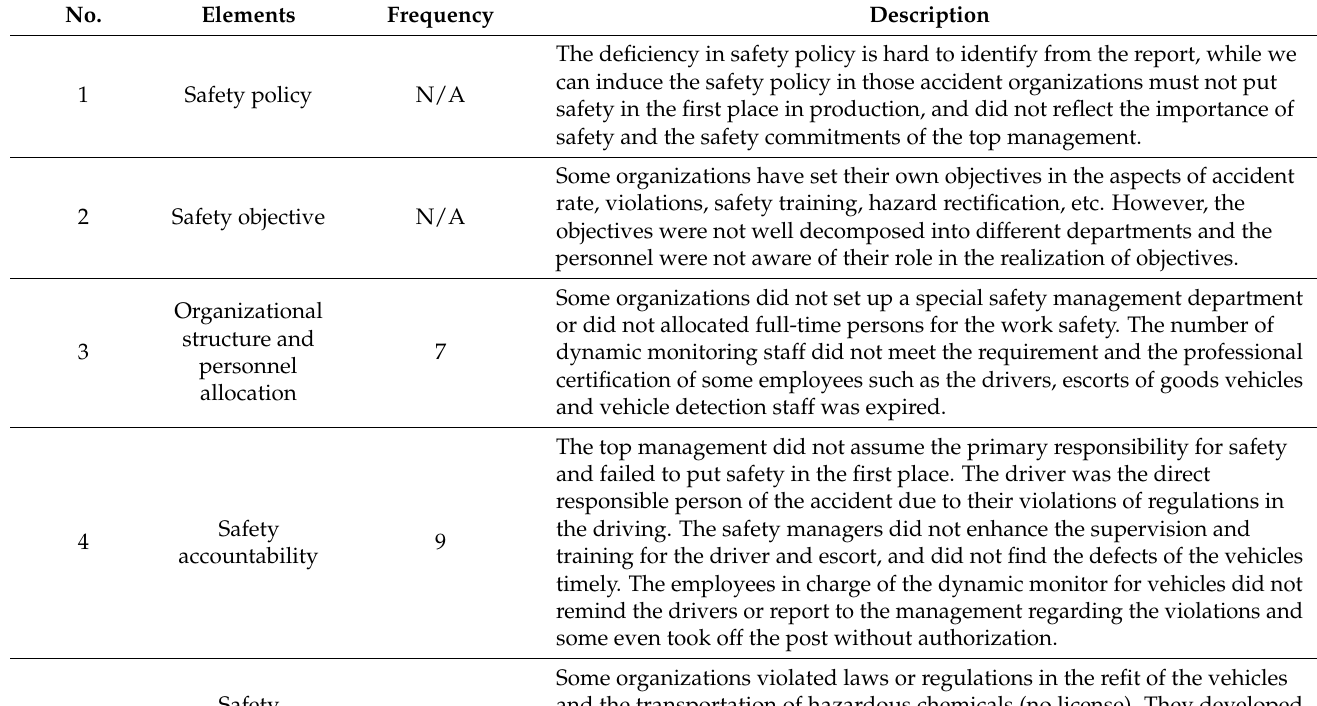
Table 6. Deficiencies in the safety management system leading to the commercial vehicle